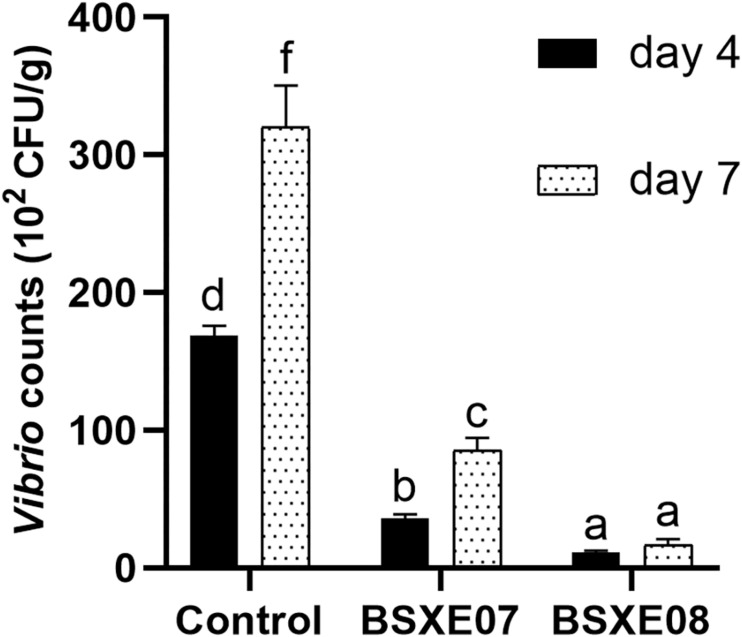
The resistant activity of BSXE-1601 against Vibrio spp. in the hepatopancreas of shrimp on day 4 and day 7 with different concentrations of BSXE-1601. Results are expressed as mean ± standard error of three replicates. Values marked with a different letter are significantly different (P < 0.05).